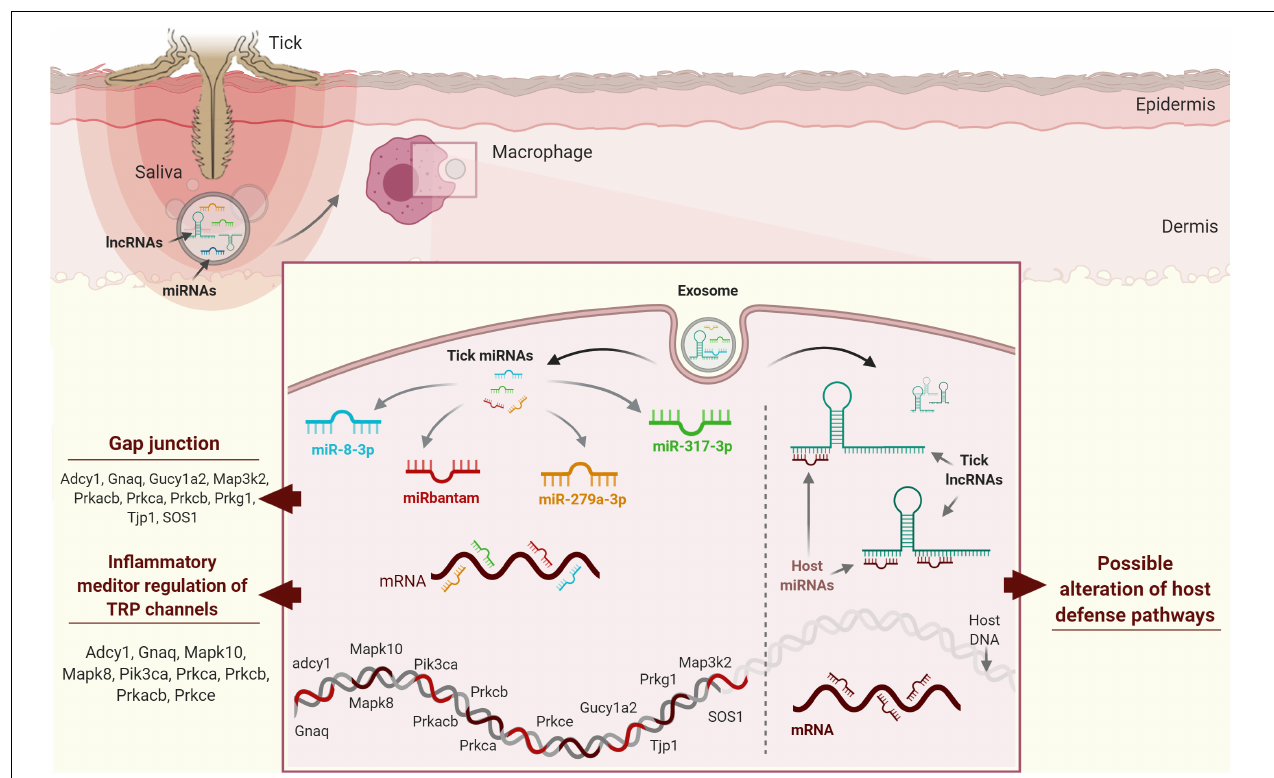
FIGURE 4 | Possible strategies used by tick ncRNAs in host cells. (A) miR-8-3p, bantam-3p, mir-317-3p, and miR-279a-3p from Ixodes ricinus have been predicted to target gap junctions and inflammatory mediator regulation of TRP channels, which play a role in host homeostatic responses. (B) Host miRNAs regulate protein coding genes through mRNA cleavage and/or direct translational repression and/or mRNA destabilization. Ticks secrete exosomes in their saliva containing lncRNAs, which may compete with host mRNAs for host miRNA binding by acting as “sponge” molecules that inhibit host miRNA interactions with host mRNAs, thus affecting host homeostatic responses to tick